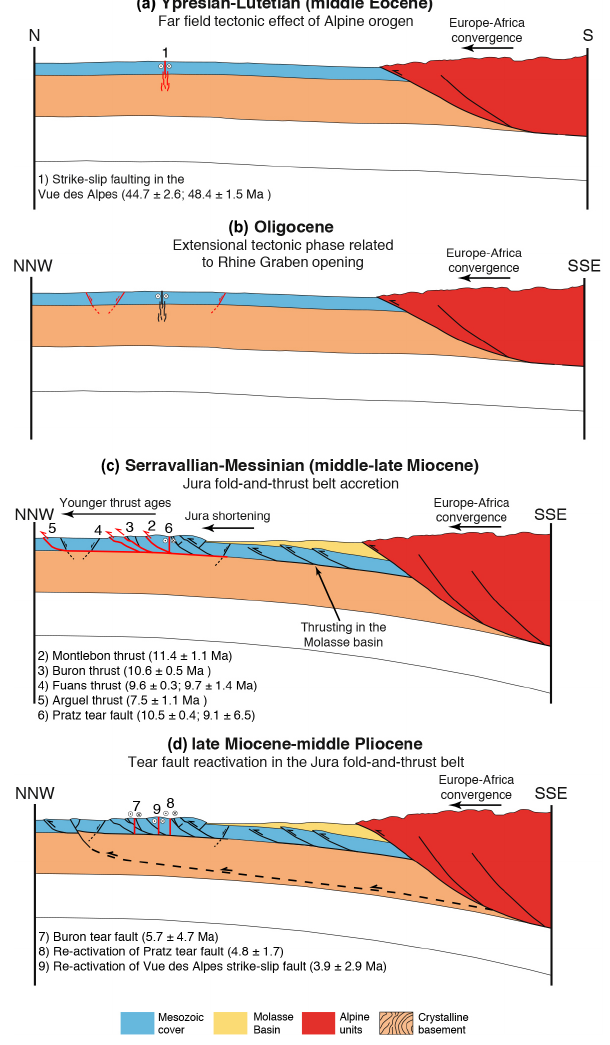
Figure 8. (a–d) Schematic reconstruction of the main tectonic phases dated in the Jura area in the regional context of the Alpine foreland system